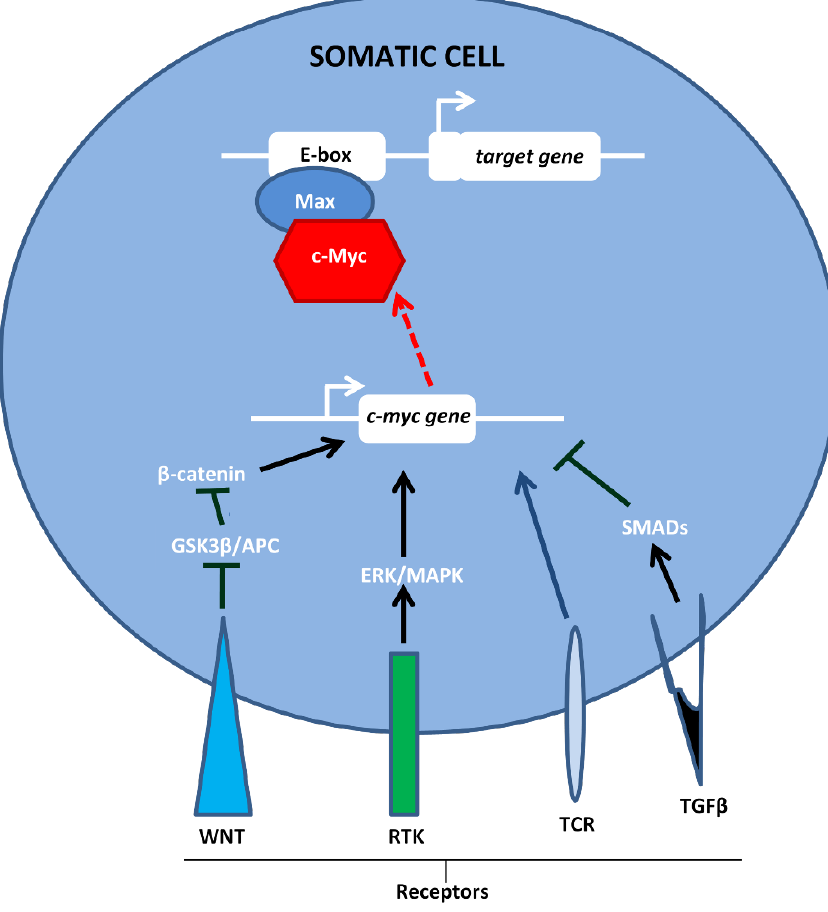
Figure 1. Transcription of the c-myc gene in normal cells occurs in response to signals from membrane-anchored receptors. White arrows show the direction of transcription (adapted from [18]).